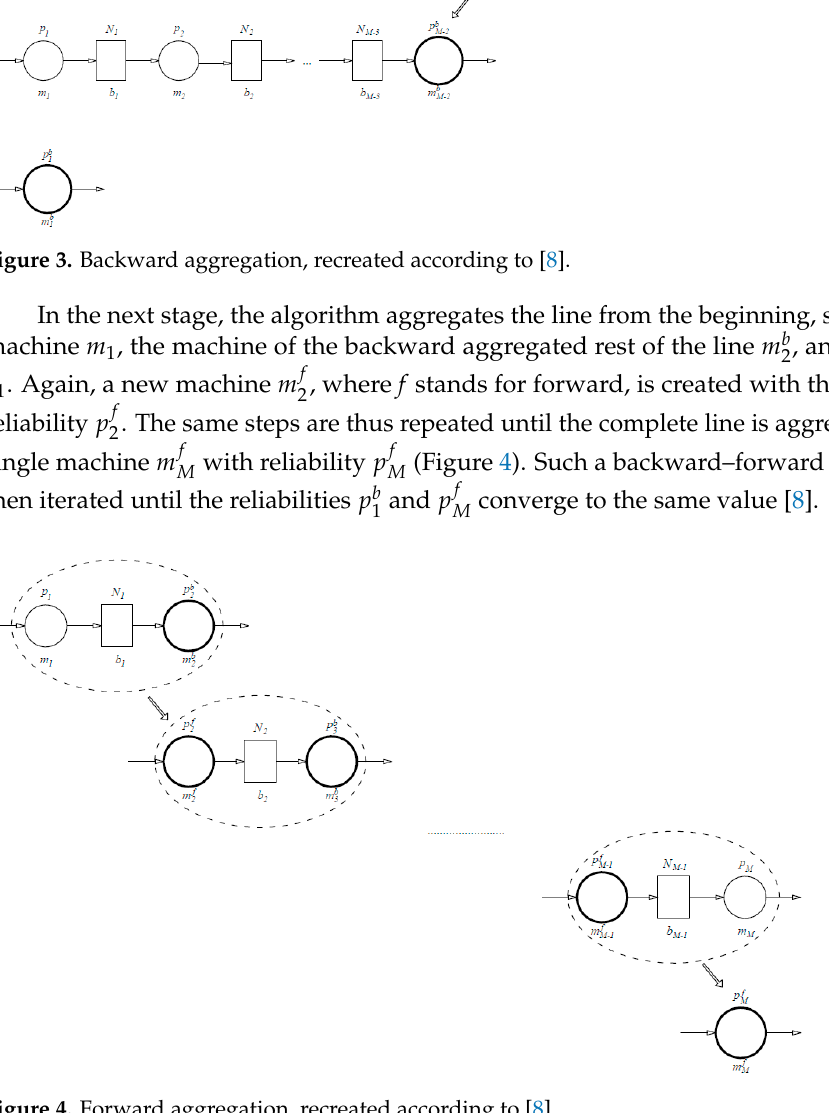
Figure 4. Forward aggregation, recreated according to [8].